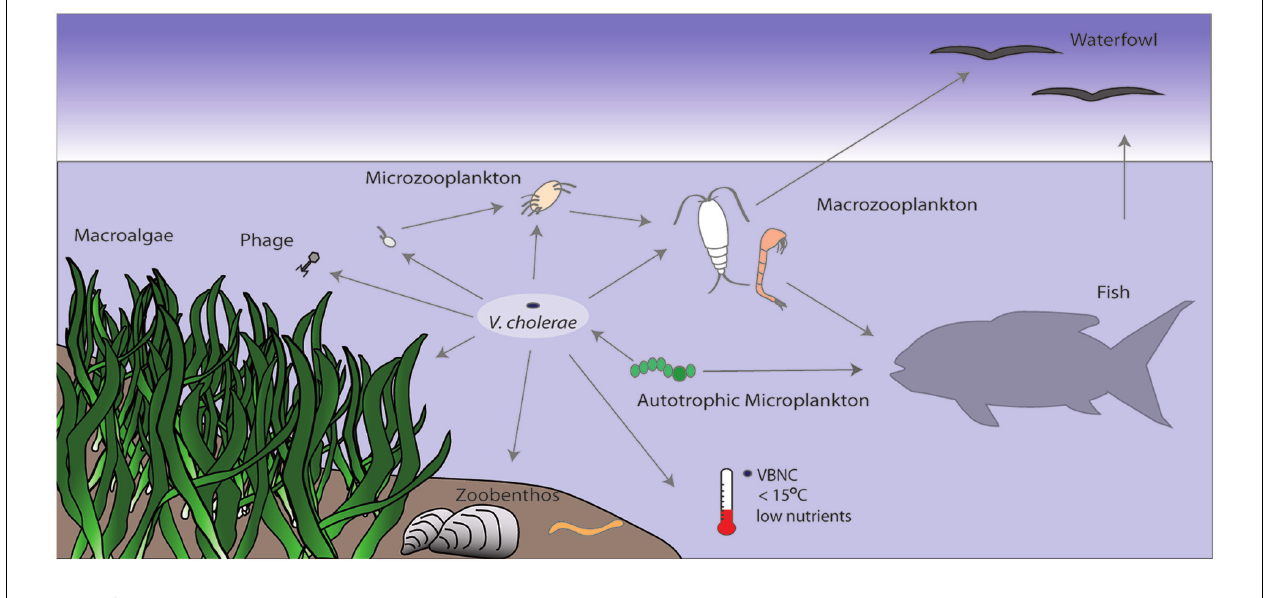
also attach to autotrophic organisms such as phytoplankton or macroalgae, which can provide a carbon source. Attachment to chitinous zooplankton and gelatinous egg masses (e.g., chironomids) provide nutrients and also facilitate HGT. Fish and birds feed on plankton or mussels that might harbor V. cholerae and can potentially spread the bacterium across long